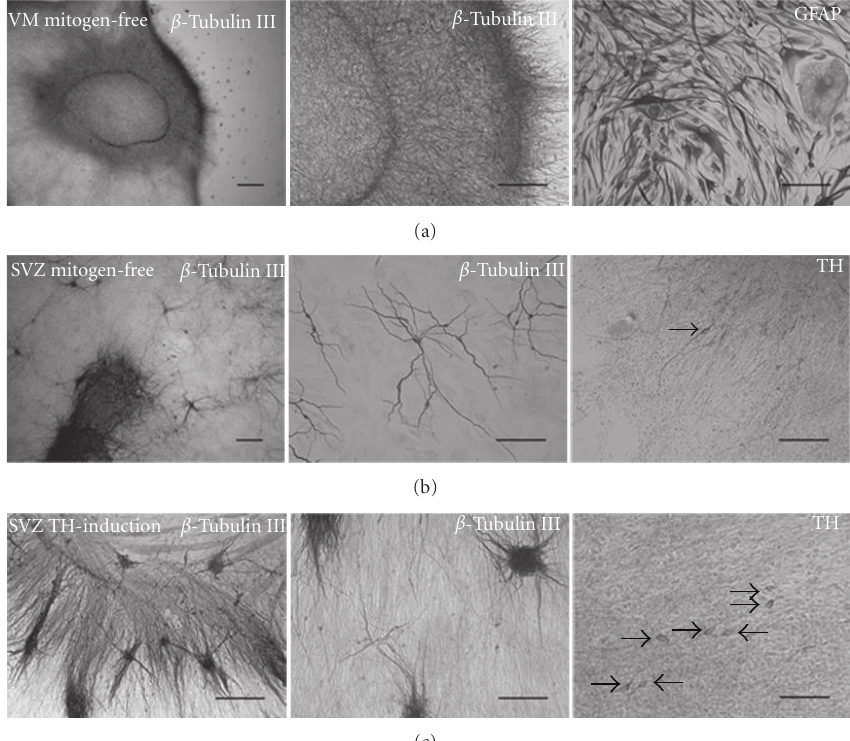
Figure 6: Di ff erentiation of long-term propagated embryonic porcine neural tissue spheres (NTS). Di ff erentiation of VM NTS (51 and 170 days of age) induced by mitogen withdrawal did after 25 days induce a high number of β Tubulin III positive cells in the central core of the di ff erentiated NTS (a), but no TH-positive cells were identified. Instead, the di ff erentiated cells primarily expressed the astroglial marker GFAP and displayed a characteristic astroglial morphology. To verify the di ff erentiation potential of the protocols used, 51-day-old NTS cultures derived from the embryonic porcine subventricular zone (SVZ) were included in the di ff erentiation study as a positive control. Di ff erentiation of SVZ NTS for 25 days by mitogen withdrawal (b) or by addition of the TH-inducing factors a-FGF, forskolin, TPA, and db- cAMP (c), known to stimulate TH expression in mammalian forebrain cultures, both resulted in β Tubulin III- and TH-positive cells. The β Tubulin III-positive cells had a characteristic neuronal morphology and were located in clusters/clones in the zone of migrating cells and in the central core of the di ff erentiated SVZ NTS. The TH-positive cells were more numerous and appeared more morphologically immature by having shorter processes (c) compared to the cultures di ff erentiated under mitogen-free conditions (b). Arrows mark soma of TH-positive cells. Scale bars = 200 μ m and 100 μ m in microphotographs of β Tubulin III expression at low and high magnification, respectively. 100 μ m in microphotographs of GFAP and TH